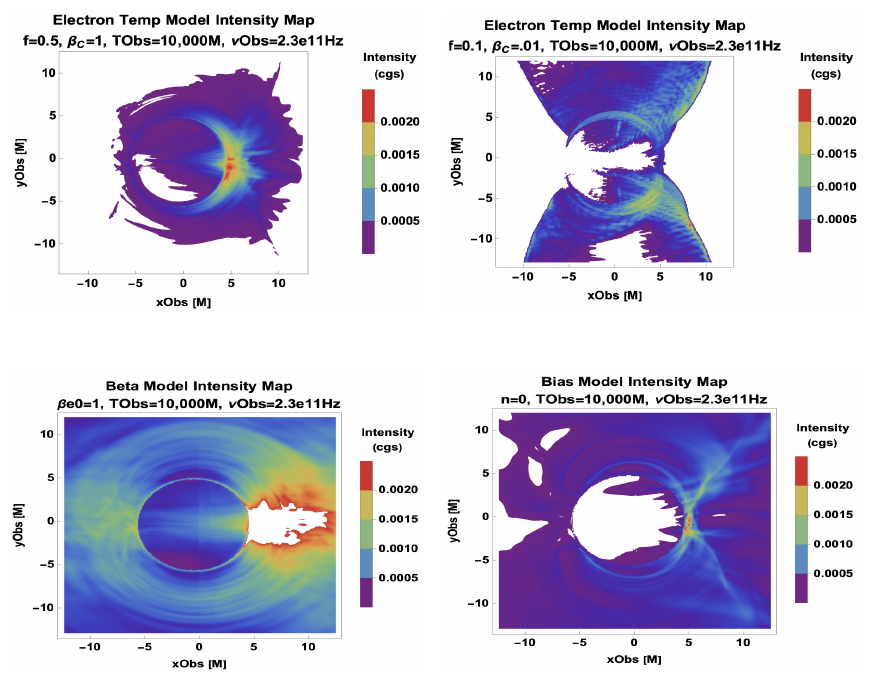
Figure 6. Semi-MAD simulation [9] model classes that were ray traced at 230 GHz at T = 10,000 M , as shown in Figure 5, but with a common intensity